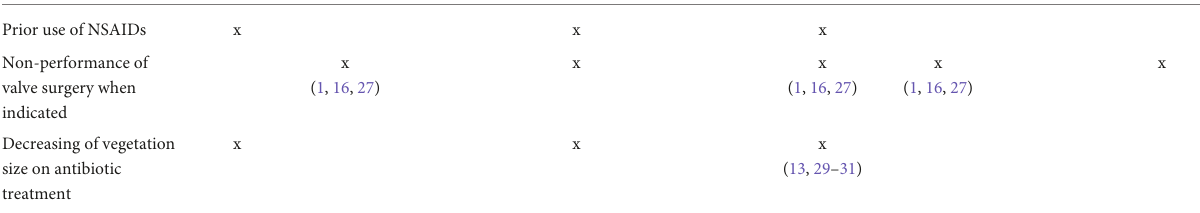
TABLE 5 The potential prognostic factors relevance in Staphylococcus aureus endocarditis assessed by the Hill criteria. Strength Consistency Specificity Temporality Biological